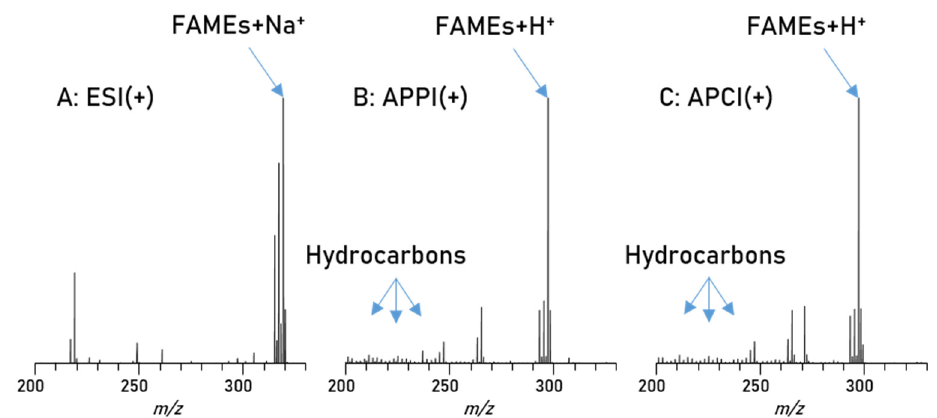
Figure 2. Spectra of blend 1, measured with different ionization techniques; ( A ): ESI(+) reveals only a very limited numbers of non-polar diesel compounds, ( B ): APPI(+); here some non-polar diesel compounds can be detected although the polar biodiesel compounds significantly influence the intensity, ( C ): APCI(+) shows similar results, as petrodiesel compounds are present in low intensity while biodiesel compounds appear with higher intensities.